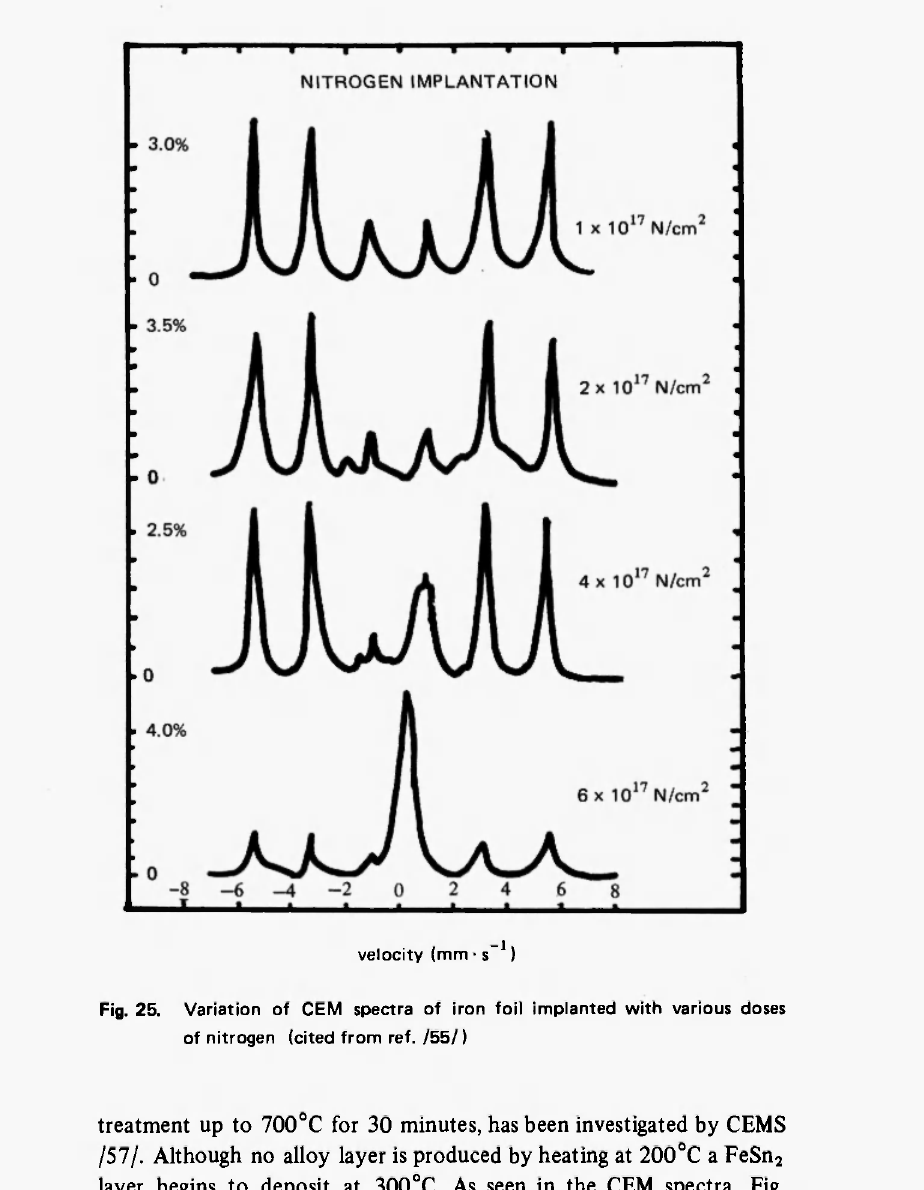
Fig. 25. Variation of CEM spectra of iron foil implanted with various doses of nitrogen (cited from ref.